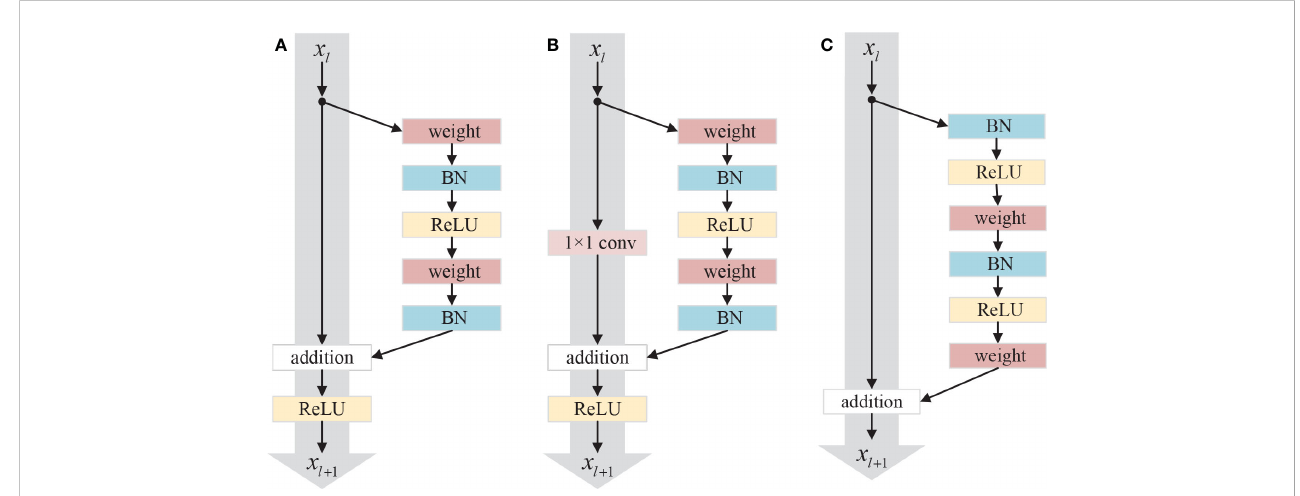
FIGURE 2 Three different residual units: (A) Original residual unit; (B) Conv residual unit; (C) Improved residual